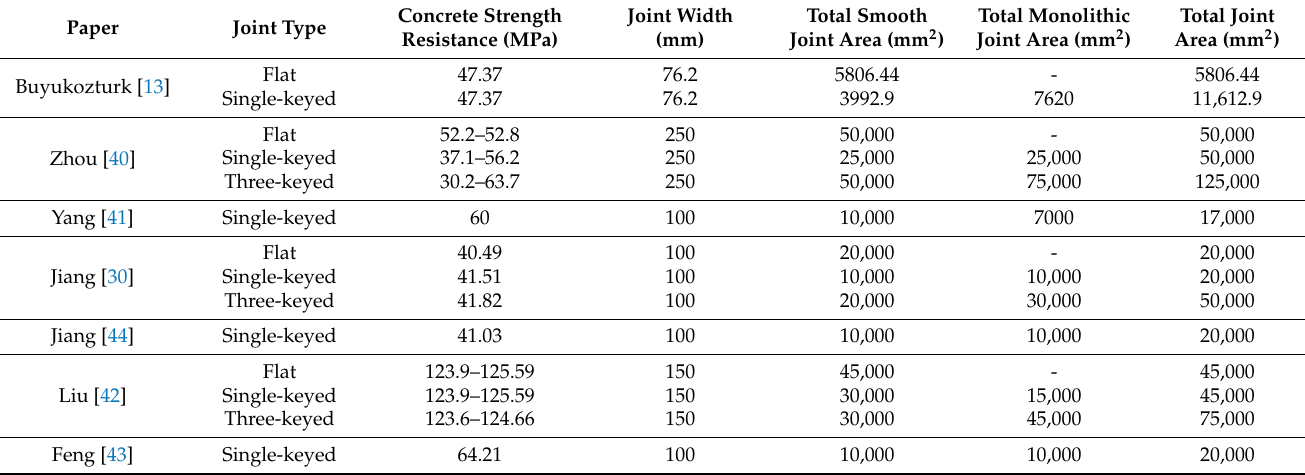
Table 10. Information about dry joints specimens from previous papers.